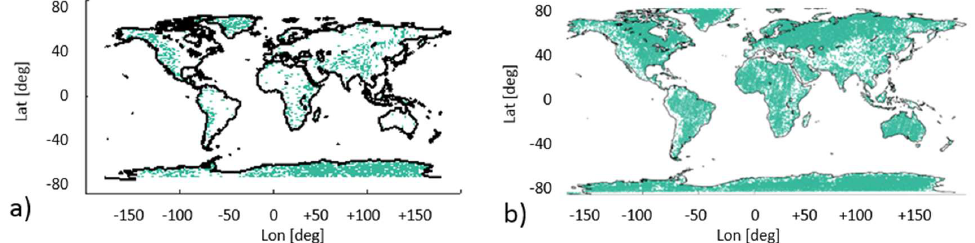
Figure 3. ( a ) Pixels corresponding to different ranges of DDM delay spread ( σ τ ) and DDM Doppler